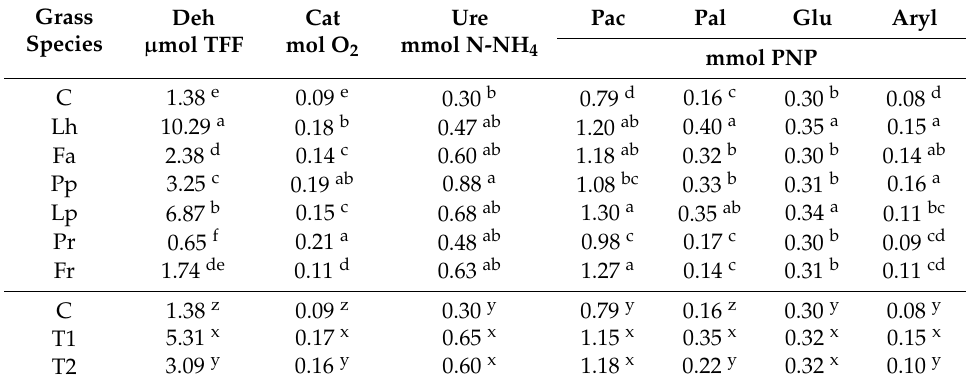
Table 5. Enzymatic activity in 1 kg d.m. of soil per 1 h.